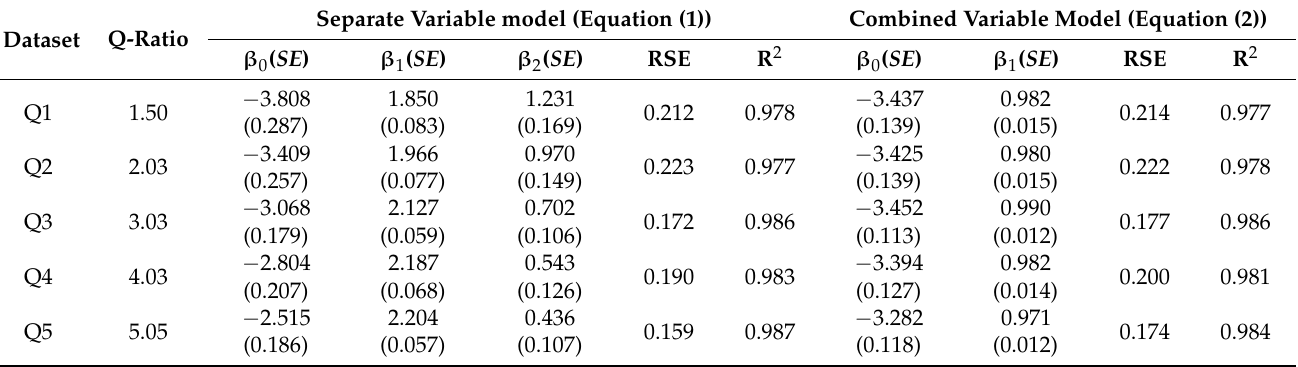
Table A1. The estimates of model